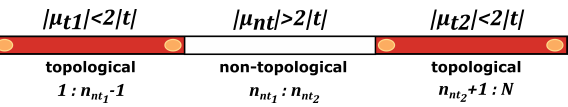
to n . There nt 1 nt 2